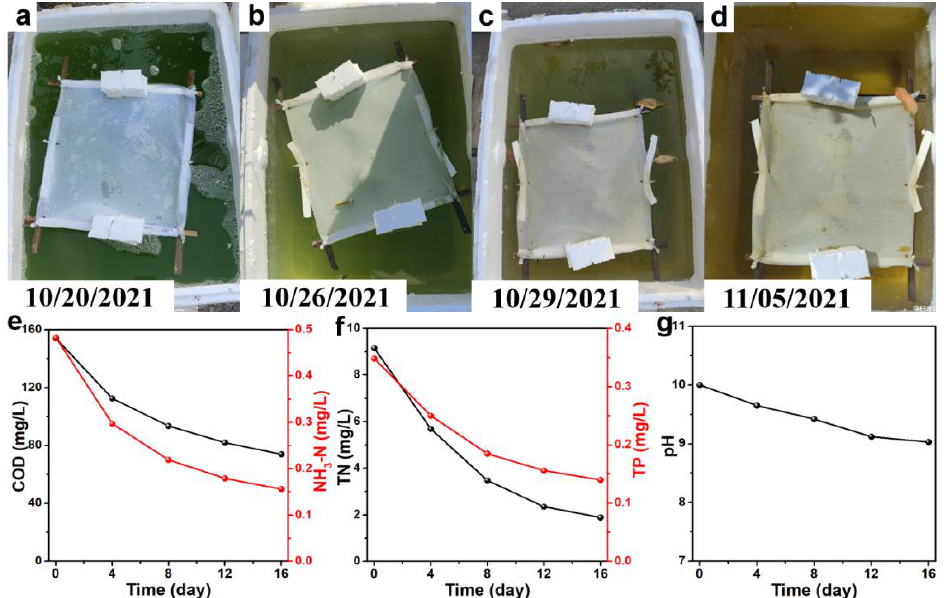
Figure 3. ( a ) – ( d ) Photos of photocatalytic processes of the FPM in autumn (20 October~5 November 2021); photocatalytic performance of the FPM for domestic sewage treatment: ( e ) COD and NH 3 -N removal; ( f ) TN and TP removal; ( g ) pH value.